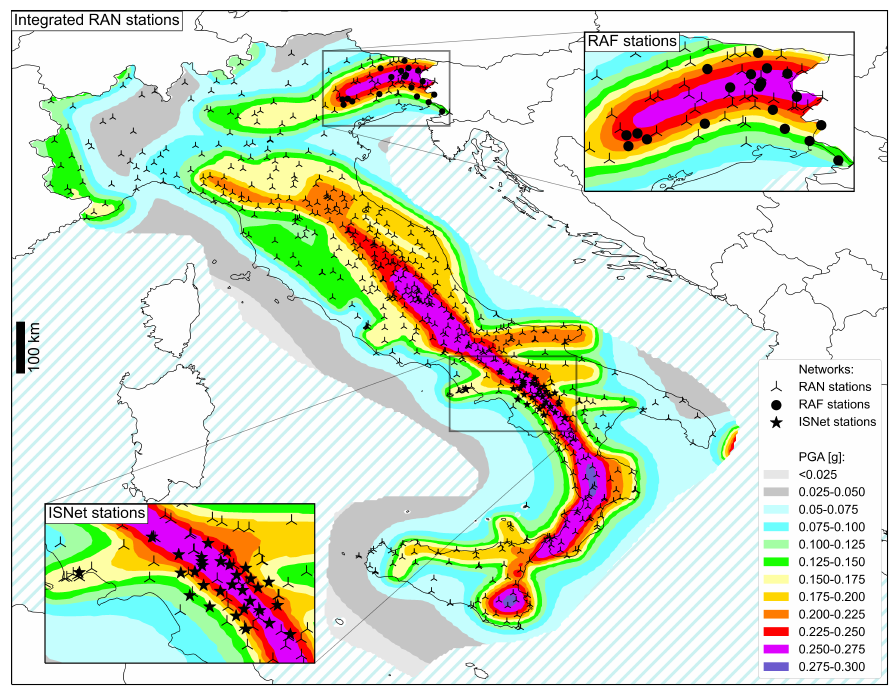
Figure 1. Distribution of the strong motion stations of the RAN (triangle markers) and its tributary networks: the ISNet in the south (star markers, [28] http://isnet.unina.it/, last access: 16 June 2022) and the RAF in the north-east (dots, [27] http://seisram.units.it/, last access: 16 June 2022). The base map is the Italian seismic hazard maps retrieved from http://esse1.mi.ingv.it/d2.html (last access: 16 June 2022), for a return period of 475, i.e., a probability of excess of 10% in 50